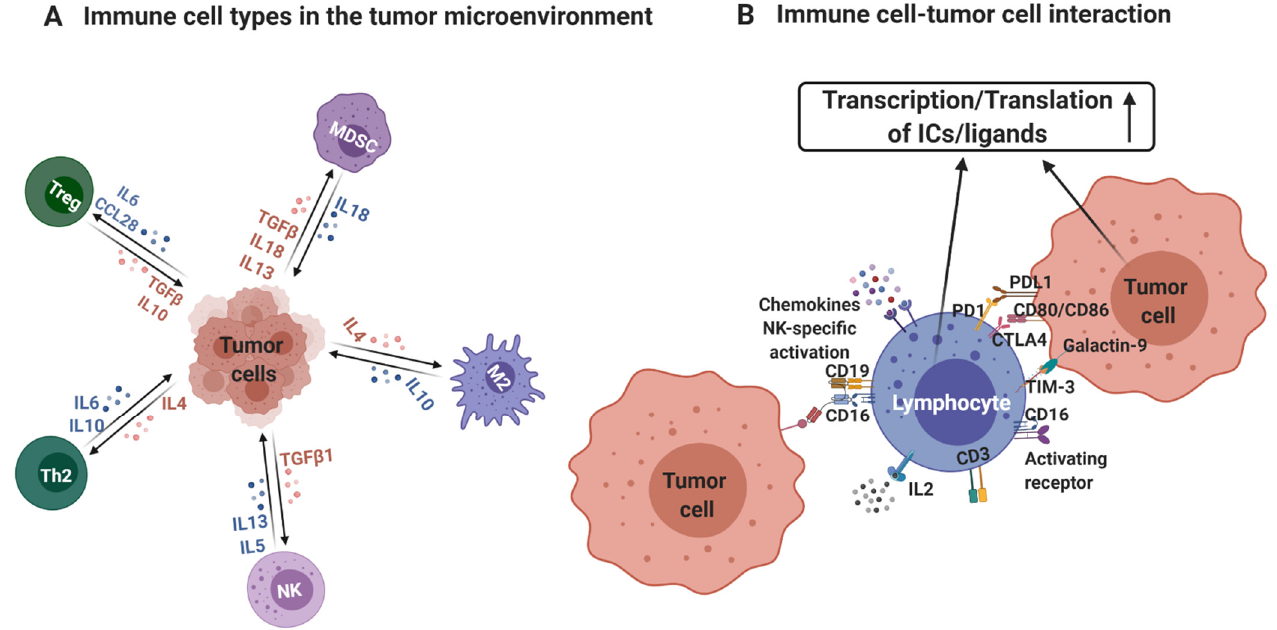
Figure 6. Schematic representation of the upregulation of immune checkpoints/ligands within the tumor microenvironment. Figure shows the immune cell types within the tumor microenvironment (TME) and corresponding cytokines/chemokines for their differentiation and trafficking to the TME ( A ). Immune cells (B cells/NK cells/T cells) express multiple immune checkpoints such as PD-1, CTLA-4, and TIM-3, while tumor cells express PD-L1, CD80/86, and Galectin-9. These immune checkpoints bind with corresponding ligands leading to their transcriptional and translational upregulation through various post-transcriptional/translational modifications ( B ).